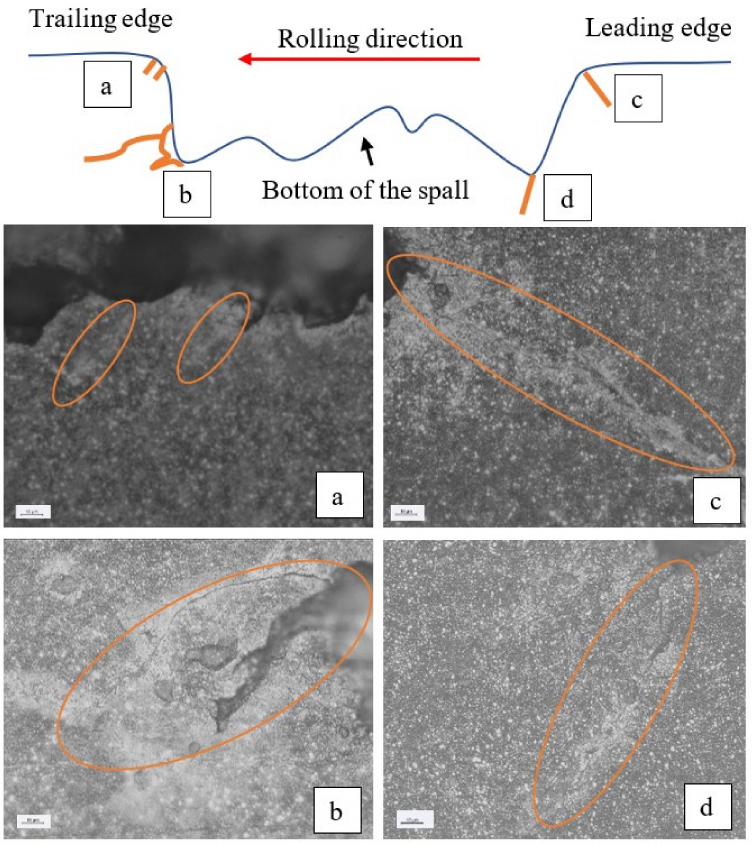
Figure 18. SEM images from the spall: ( a ) The top of the trailing edge of the spall, ( b ) the bottom of the trailing edge, ( c ) the top of the leading edge of the spall, and ( d ) the bottom of the leading edge. The Orange ovals mark the cracks.